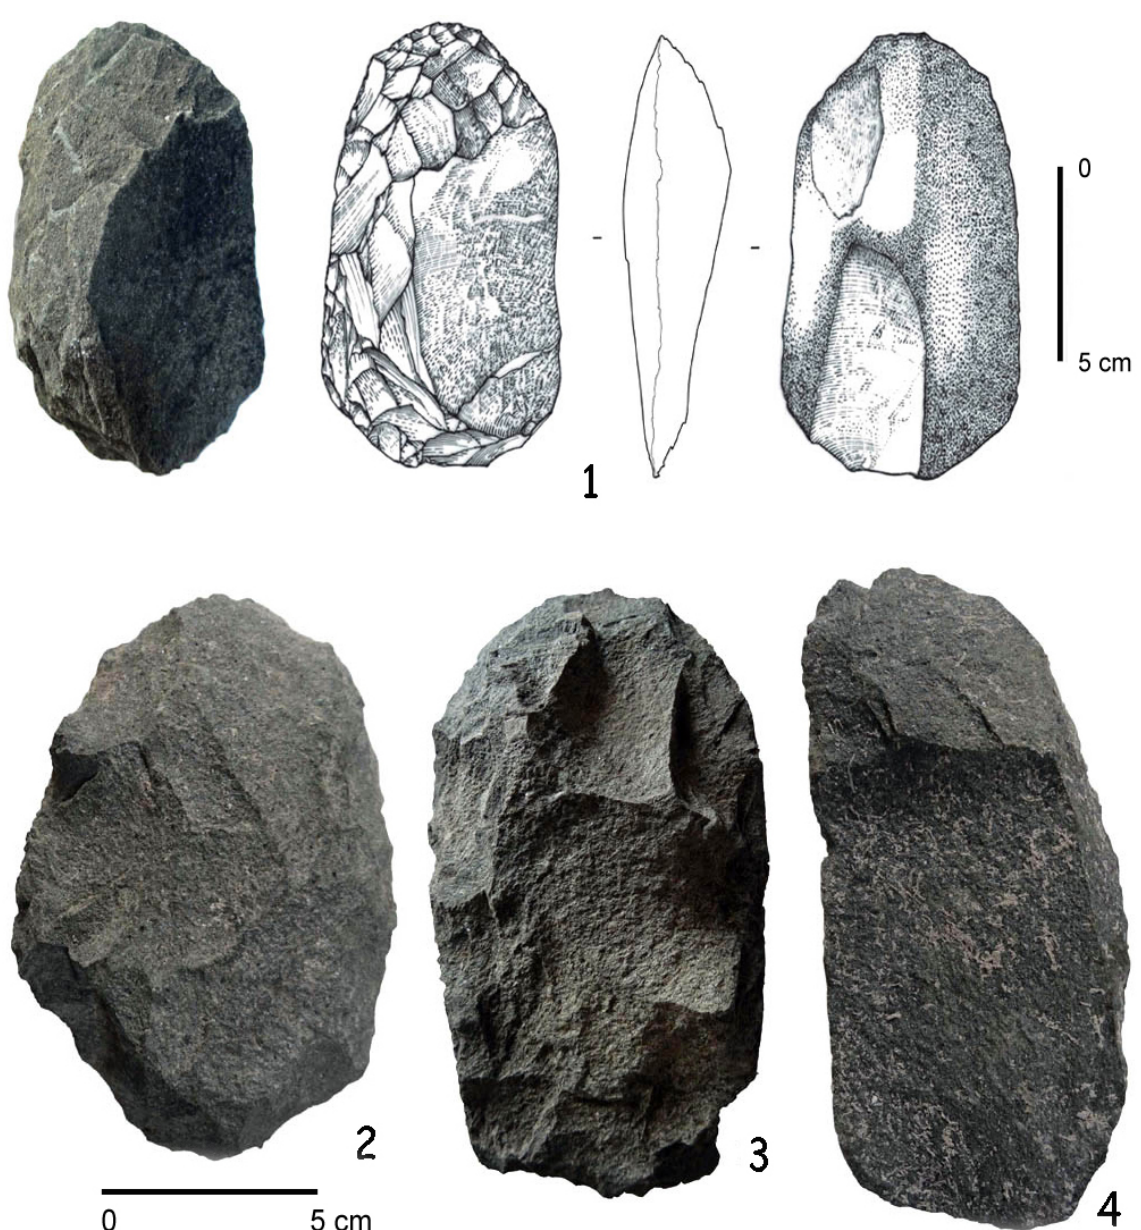
Figure 8. Diversité d’un outillage sur split de galets hoabinhiens, Laang Spean, Cambodge. 1 : chopper latéral ; 2-3 : unifaces ; 4 : outil sur split (denticulé latéral et distal). Figure 8. Diversity of hoabinhian split pebble tools, Laang Spean (Cambodia). 1: lateral chopper; 2-3: unifaces; 4: outil sur split (denticulé latéral et